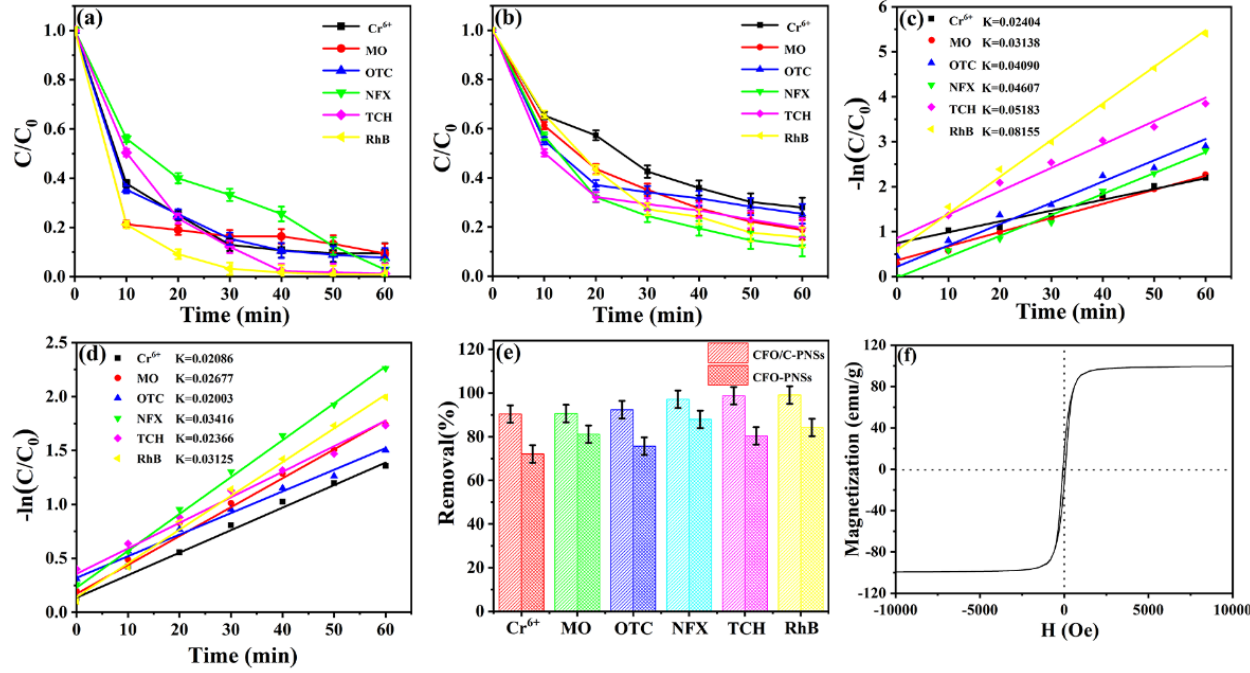
Figure 5. The visible-light photocatalytic performance of ( a ) CFO/C-PNSs and ( b ) CFO-PNSs for photoreduction of Cr(VI) and degradation of MO, OTC, NFX, TCH and RhB. The corresponding reaction rate constant k is shown as ( c ) and ( d ), respectively. ( e ) The removal rate of CFO/C-PNSs and CFO-PNSs for Cr(VI) MO, OTC, NFX, TCH and RhB. ( f ) Hysteresis loop diagram of CFO/C-PNS photocatalysts.